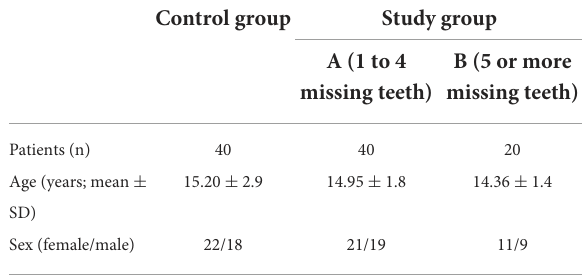
TABLE 3 The angular and linear soft tissue measurements and their descriptions.